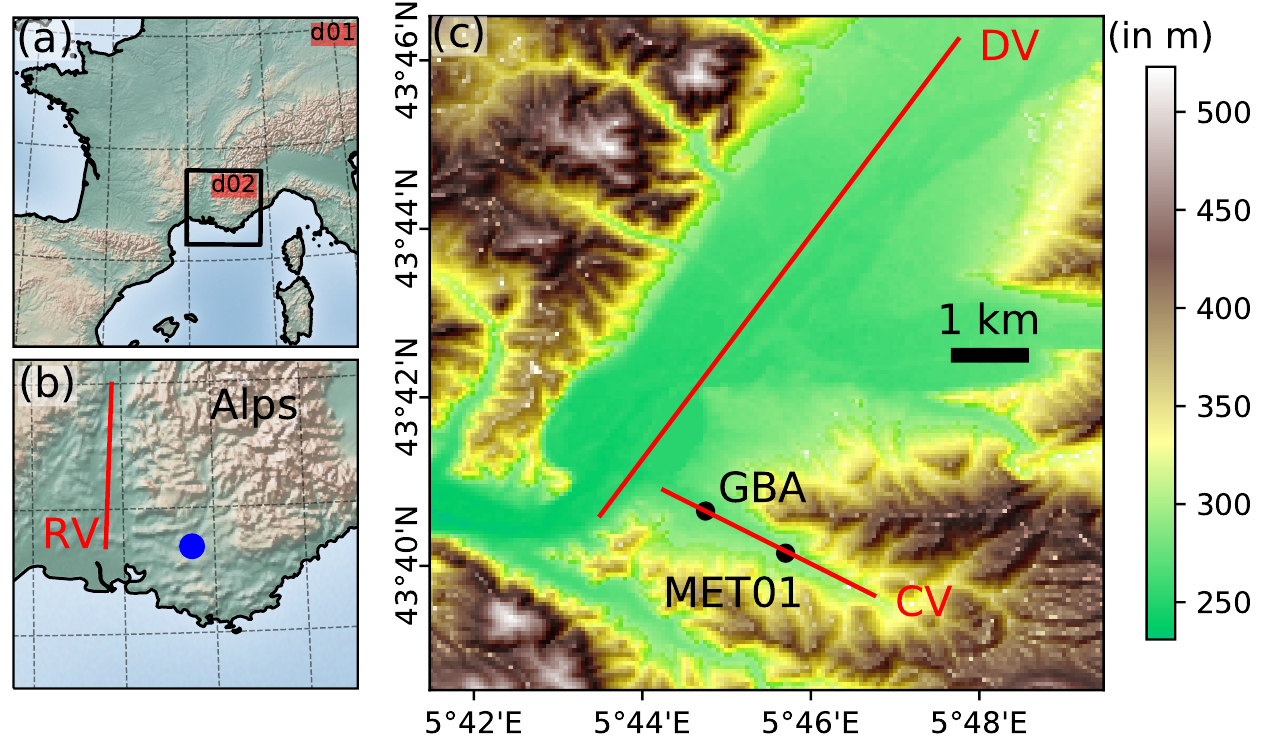
Figure 1. ( a ) Representation of the Weather Research and Forecasting (WRF) domain #1 (full image). The black square in subfigure ( a ) represents the WRF domain #2. Subfigure ( b ) is a zoom on the domain #2. RV stands for Rhône Valley. The blue dot indicates the location of the Cadarache region. Subfigure ( c ) represents the topography over the Cadarache region. Black dots indicate the locations of the routine measurement meteorological stations MET01 and GBA. Source: https://www.naturalearthdata.com/ for subfigures ( a , b ), and Shuttle Radar Topography Mission (SRTM) for subfigure ( c